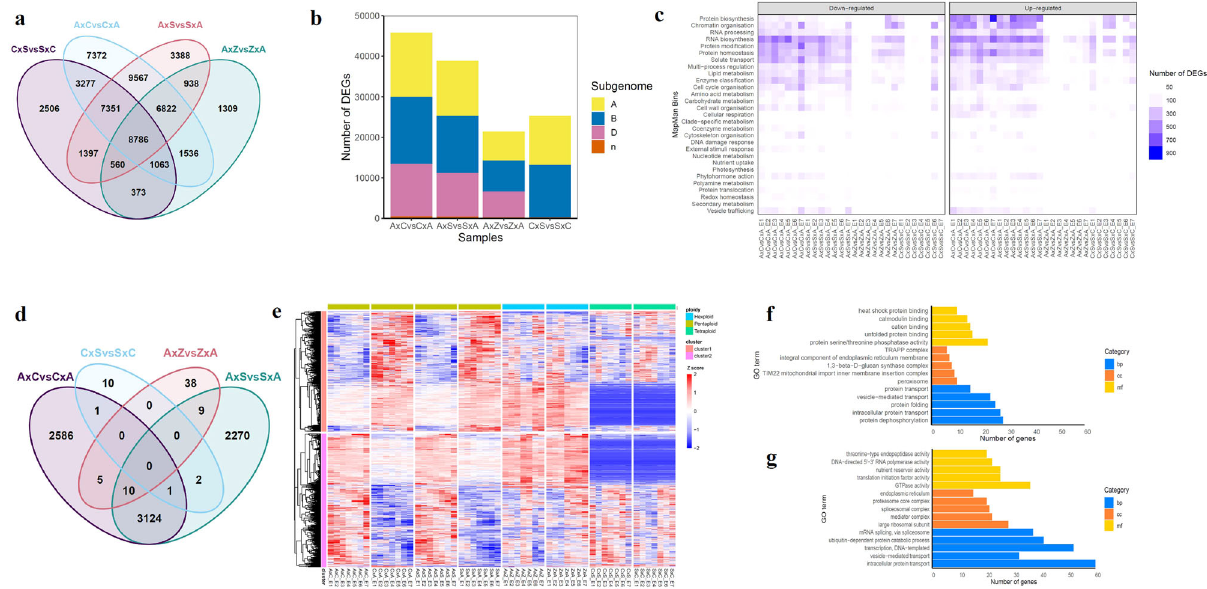
Fig. 3 Differential expression analysis between reciprocal cross pairs. a Venn diagram of DEGs between reciprocal cross pairs. b Number of DEGs between each of the reciprocal cross pair. c Number of DEGs in different pathways. MapMan bins of genes were annotated using the Mercator pipeline (http://www.plabipd.de/portal/mercator-sequence-annotation) 70 . The number of up- and downregulated DEGs between reciprocal pairs in each pathway were plotted. Upregulated DEGs represent genes that are expressed at higher levels in A×C against C×A, A×S against S×A, A×Z against Z×A and C×S against S×C. d Differentially expressed genes across all embryo stages between each reciprocal pair. ANOVA tests were performed for each DEGs to identify genes that are consistently highly or lowly expressed across seven embryo stages between each reciprocal pair (FDR < 0.05). Heatmap ( e ) and GO enrichment analysis of genes showing different expression patterns in cluster 1 ( f ) and cluster 2 ( g ) between reciprocal cross pairs across seven embryo stages. Normalized expression is scaled across genes ( Z -score) and colored in